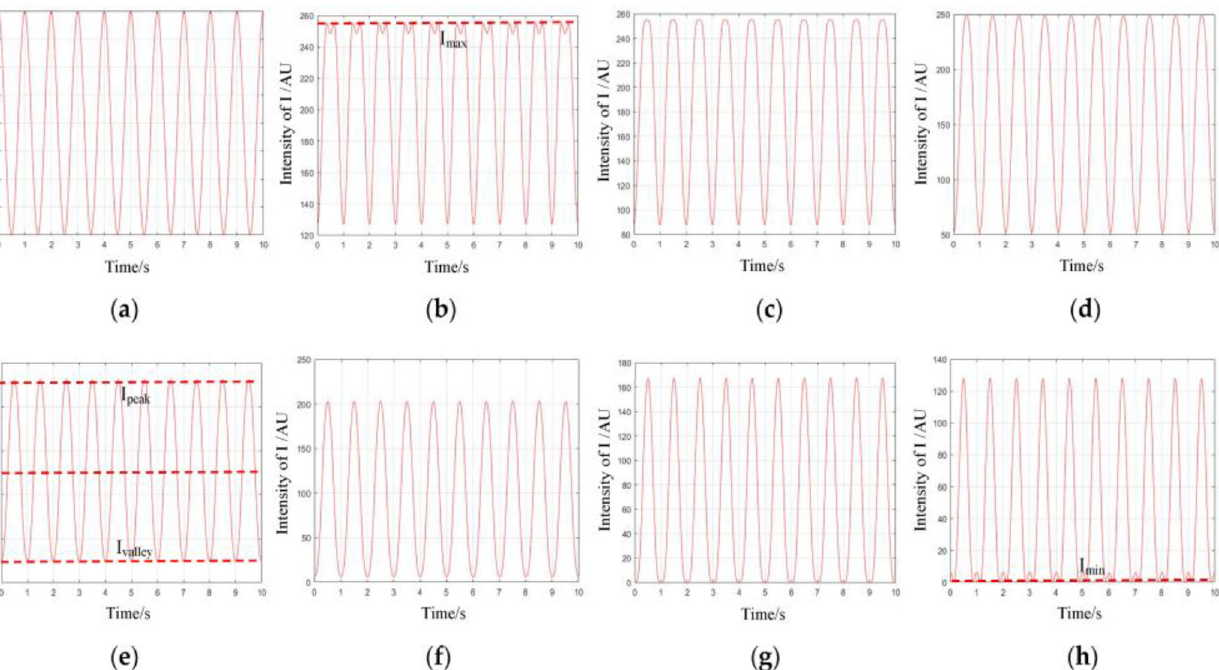
Figure 3. ( a ) is the real-time position of the measured object; ( b – h ) are the light intensity curves when σ is − 3 π /10, − 2 π /10, − π /10, 0, π /10, 2 π /10, 3 π /10.